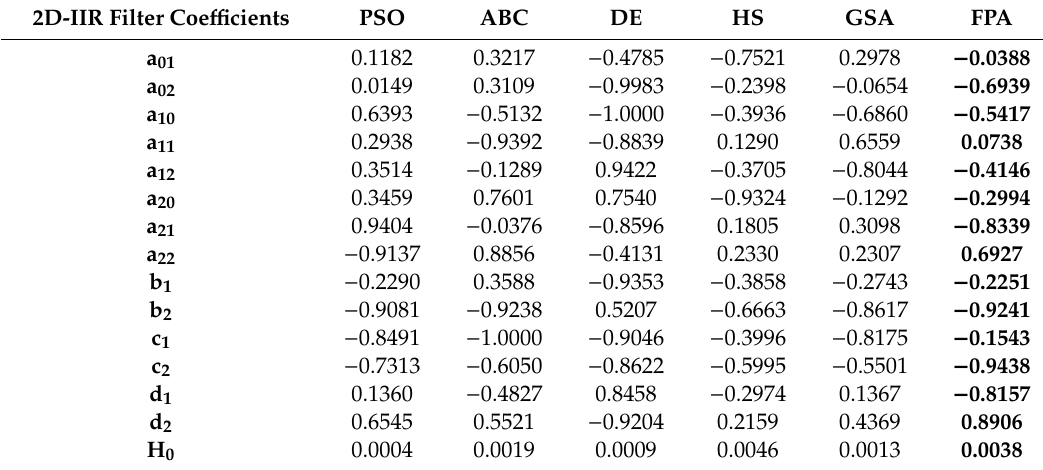
Table 2. Coe ffi cients for 2D-IIR filter design obtained by Particle Swarm Optimization (PSO), Artificial Bee Colony (ABC), Di ff erential Evolution (DE), Harmony Search (HS), Gravitational Search Algorithm (GSA) and Flower Pollination Algorithm (FPA)